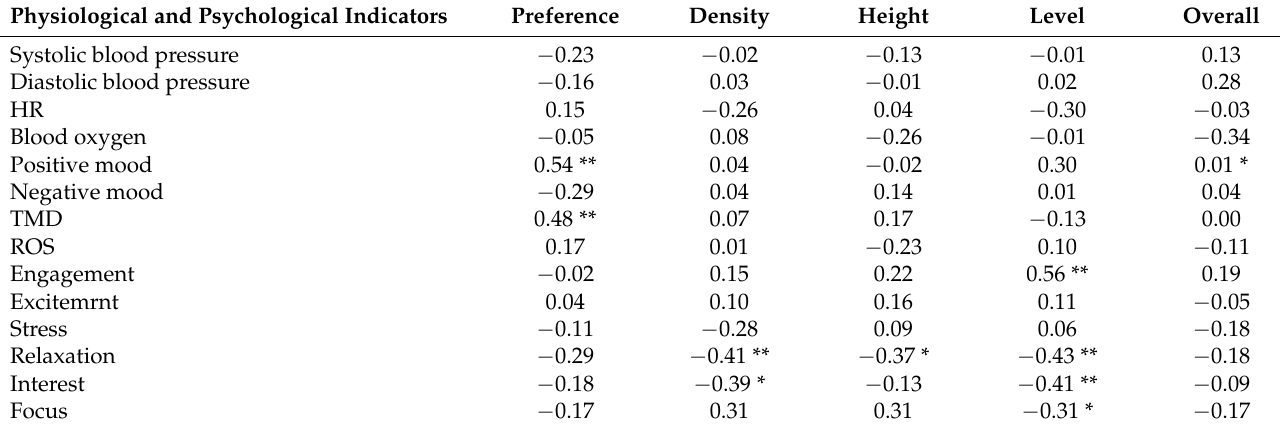
Table 4. Pearson’s coefficients for the correlations between the physiological/psychological indicators and the deciduous landscape space